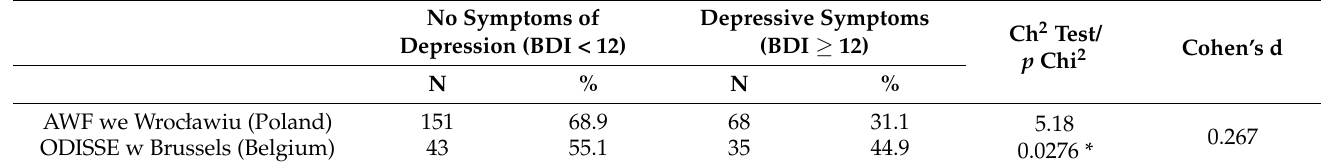
Table 4. Beck Depression Inventory (BDI) results-Lowering the mood yes/no.